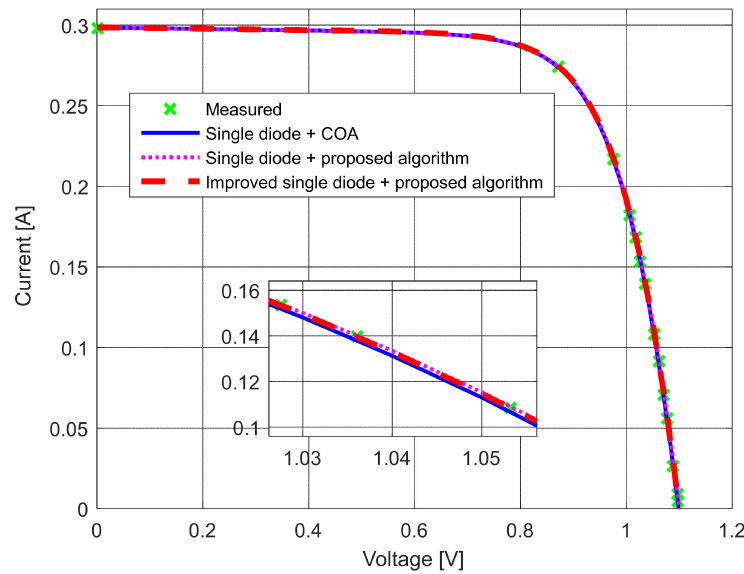
Figure 26. The measured and simulated I–U characteristics for the standard and modified single- diode models.